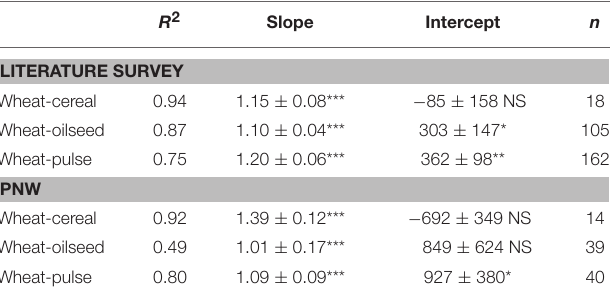
TABLE 3 | Regression parameters for the linear relationship between winter wheat yield following other cereals, oilseeds, or pulses and wheat following wheat.